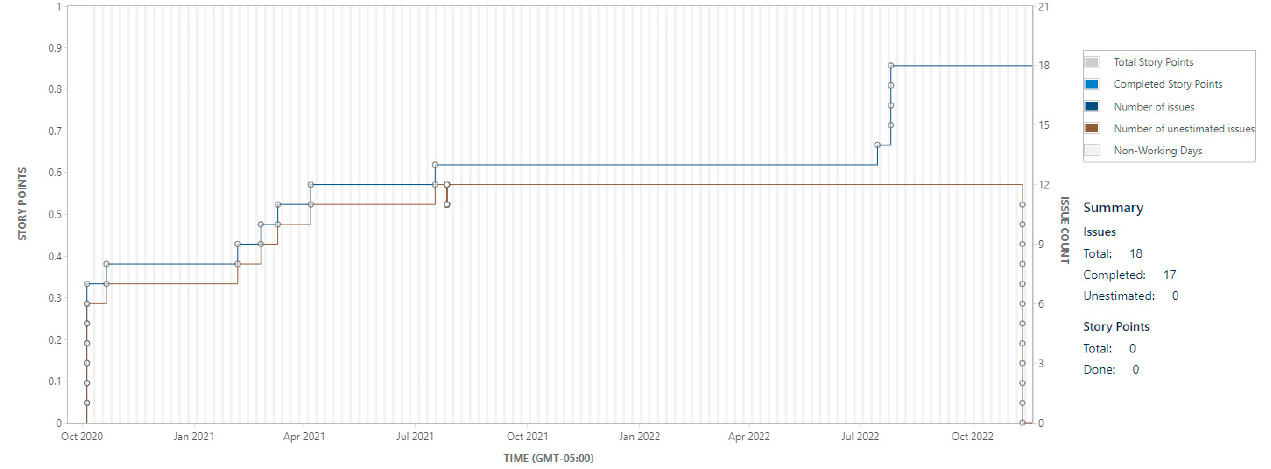
Figure 5. Jira Epic Report.